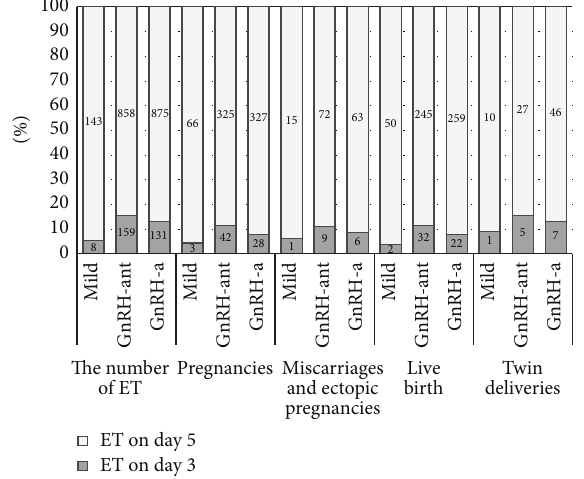
Figure 1: The outcome of COH in terms of pregnancies, miscar- riages, births, and twin deliveries according to the day of ET (day 3 cleavage embryo or day 5 blastocyst ET) (mild: GnRH antagonist mild protocol; GnRH-ant: GnRH antagonist protocol; GnRH-a: GnRH agonist